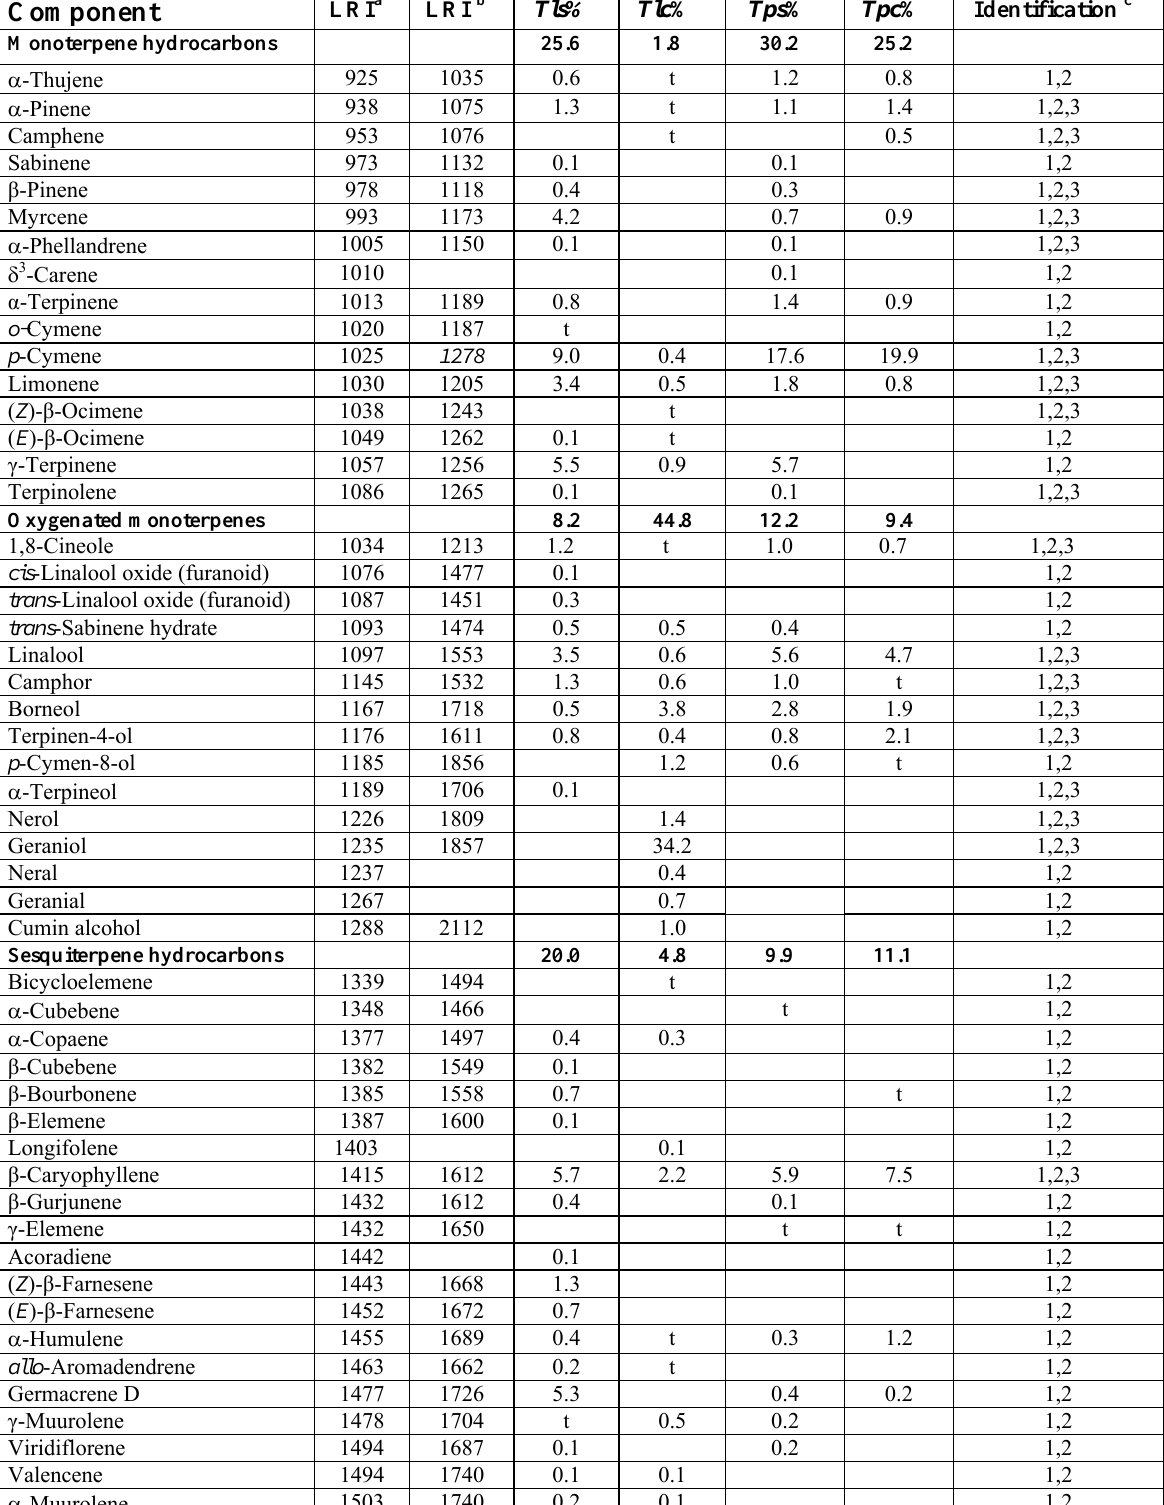
Table 1. Essential oil composition (% of total) of aerial parts of Thymus longicaulis C. Presl from Sicily ( Tls ) and from Campania ( Tlc ), Thymus pulegioides L. from Sicily ( Tps ) and from Campania ( Tpc